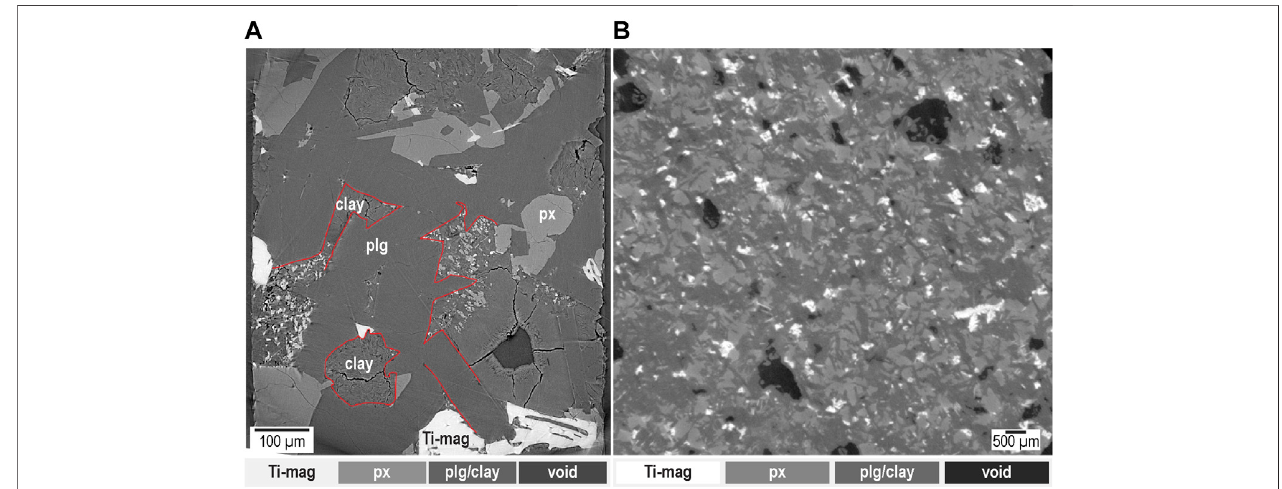
FIGURE 2 | Absorption-based synchrotron radiation and laboratory X-ray CT imaging of a partially altered crystalline basalt. Ti-mag denotes titano-magnetite, px pyroxene,plgplagioclase. (A) SRCTslicecollectedattheTOMCATbeamline,SLS,PSI,Switzerland.IncidentX-rayenergywas21keVandvoxelsizeis0.325µm.There isminimalabsorptioncontrastbetweenclayandplagioclasefeldsparbecausethesemineralshaveoverlappingµvalues( Figure1 and SupplementaryFigureS1 ),but thetwophasescanbeidenti fi edbytheirstructures(layeredforclayversusplaincrystalforplg).Aredlineisusedtoshowtheboundarybetweensomeclayminerals and some plagioclase crystals. (B) CT slice collected using a laboratory X-ray CT scanner; voxel size is (cid:5) 13 µm. Here it is not possible to differentiate plagioclase feldspar from clay because the layered structures of the phyllosilicate sheets are not resolved at this voxel size.